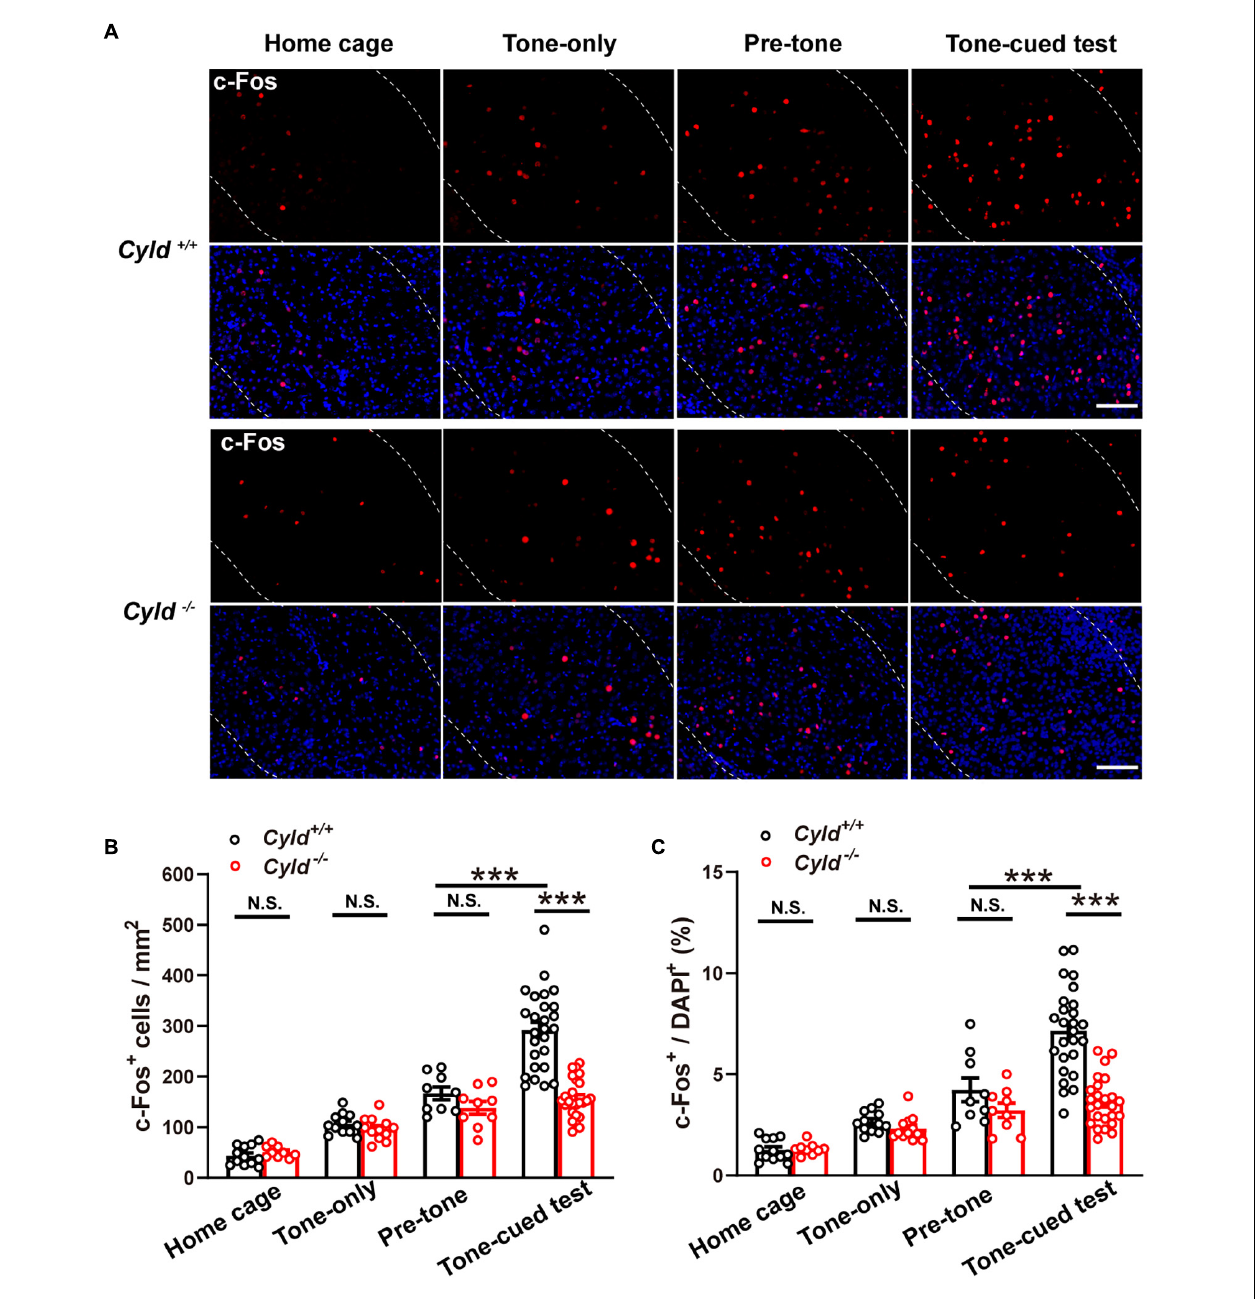
FIGURE 2 | Aberrant neuronal activation in the BLA of Cyld − / − mice. (A) c-Fos expression in the BLA of the four groups of mice with different experiences: home cage, tone-only, after pre-tone stage, and after tone-cued test. Scale bar: 100 µ m. (B,C) Quantitative analysis of the c-Fos + neuron number and the percentage of c-Fos + cells in total DAPI + cells in BLA. Home cage: n = 12 slices from four mice for the Cyld + / + group, n = 9 slices from three mice for the Cyld − / − group; tone-only: n = 12 slices from four mice for the Cyld + / + group, n = 12 slices from four mice for the Cyld − / − group; pre-tone: n = 9 slices from three mice for the Cyld + / + group, n = 9 slices from three mice for the Cyld − / − group; tone-cued test: n = 26 slices from eight mice for the Cyld + / + group, n = 25 slices from seven mice for the Cyld − / − group; two-way ANOVA, *** p < 0.001; N.S., not significant. Data are presented as mean ± SEM.